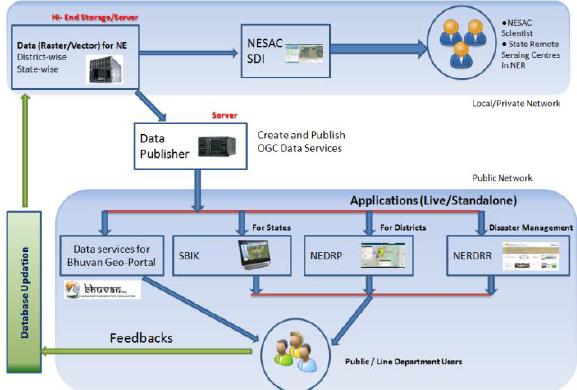
Figure 8. Storage, archival and dissemination of data